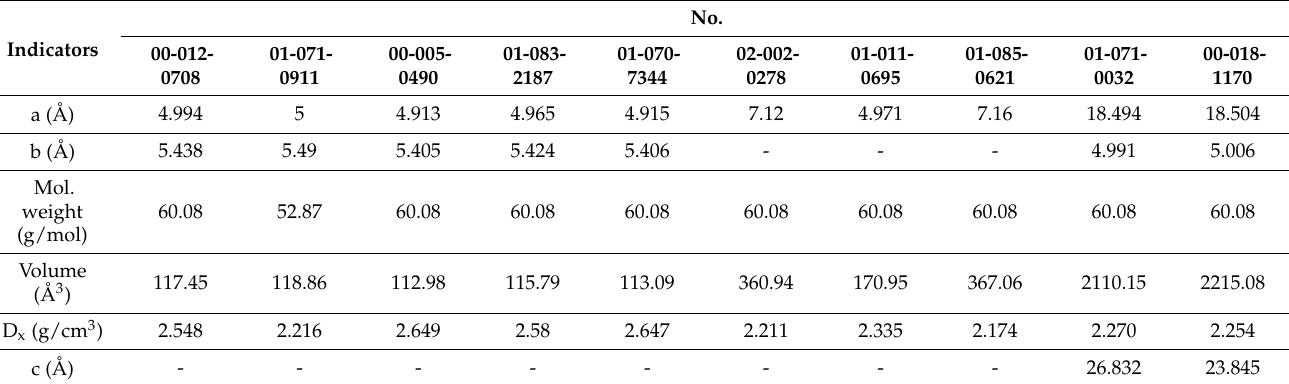
Table 2. Characteristics of elementary cell cards used in the research